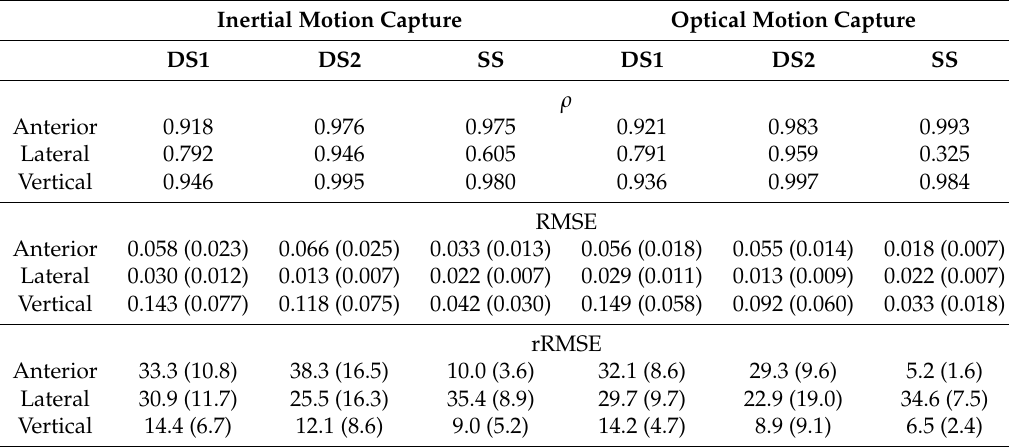
Table 4. Comparison of ground reaction forces (GRF) estimated from inertial motion capture and optical motion capture versus force plate measurements. ρ = Pearson’s correlation coefficient, RMSE = root mean square error in N/BW, rRMSE = relative root mean square error (%). Results are analyzed for all walking speeds during the gait cycle phases of first double stance (DS1), second double stance (DS2) and single stance (SS) for the decomposed right and left